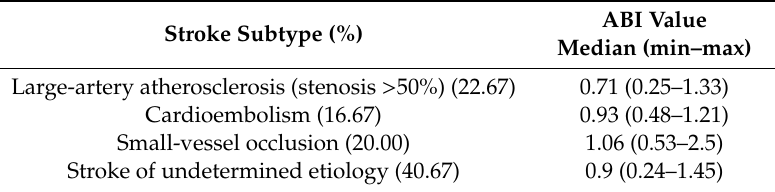
Table 7. Distribution of ABI values among stroke